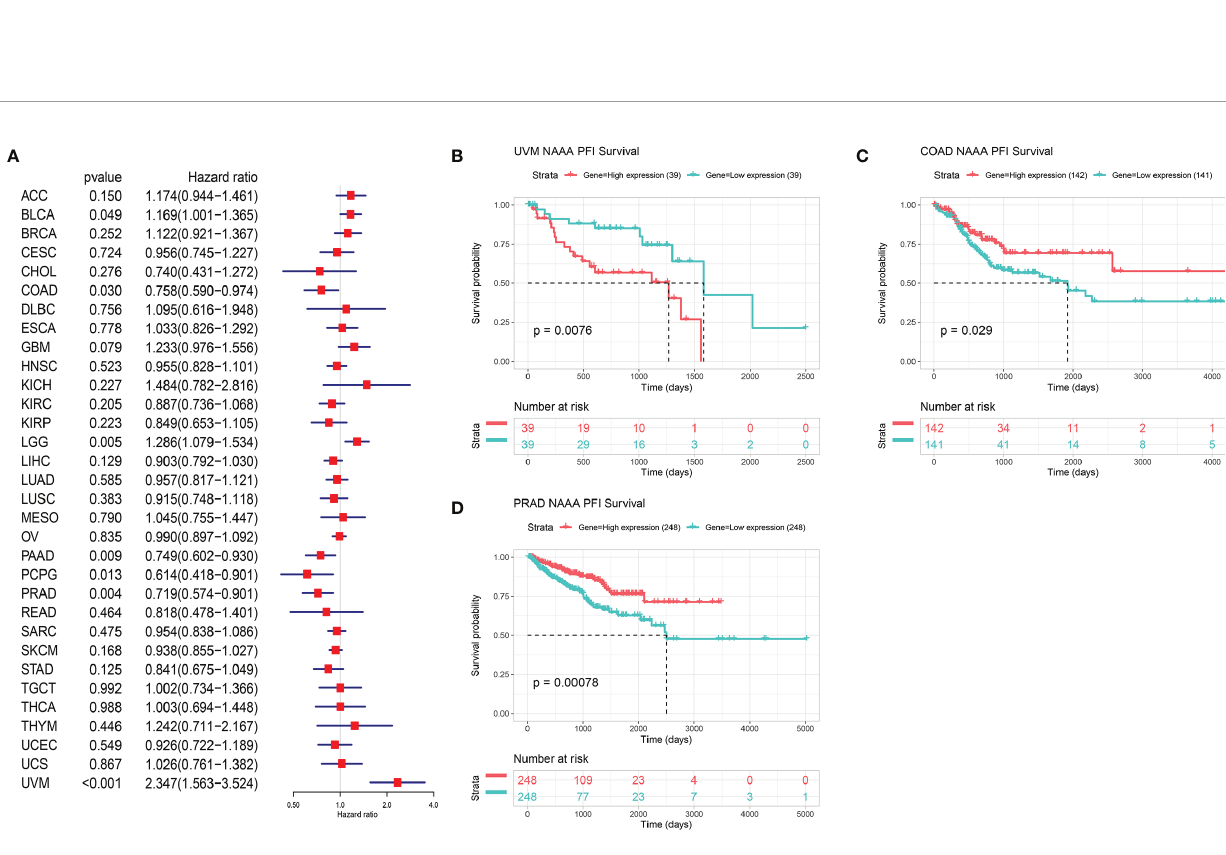
FIGURE 6 | Relationship of NAAA expression with patient Progression-Free Interval (PFI). (A) Forest map shows the univariate Cox regression analysis results for NAAA in TCGA pan-cancer samples. (B – D) Kaplan – Meier PFI curves of NAAA expression in the three most signi fi cantly associated tumors.